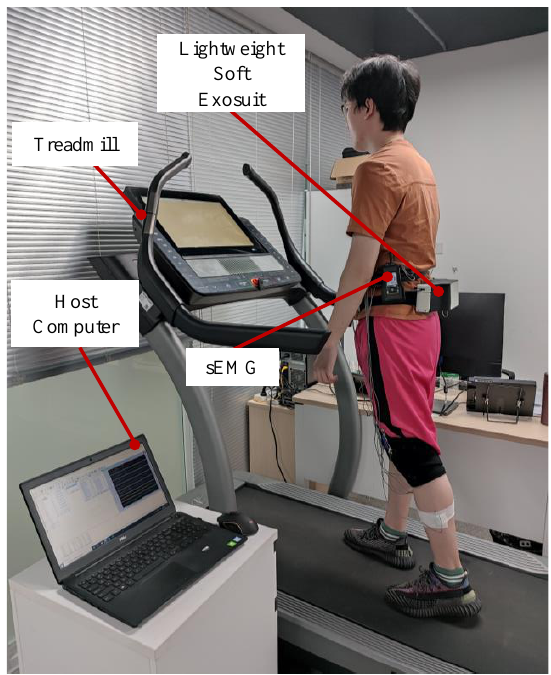
Figure 9. Evaluation experiment of the lightweight soft exosuit with sEMG device. Subjects wear the lightweight soft exosuit and measure muscle fatigue degree.